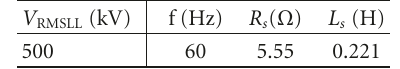
Table A.1: Parameters of source of test system 1.